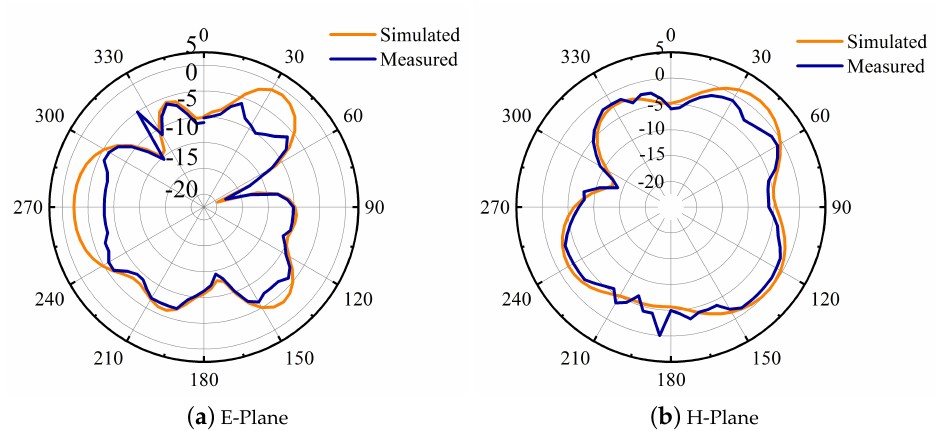
Figure 27. The measured and simulated far-field pattern for E and H plane at 10.6